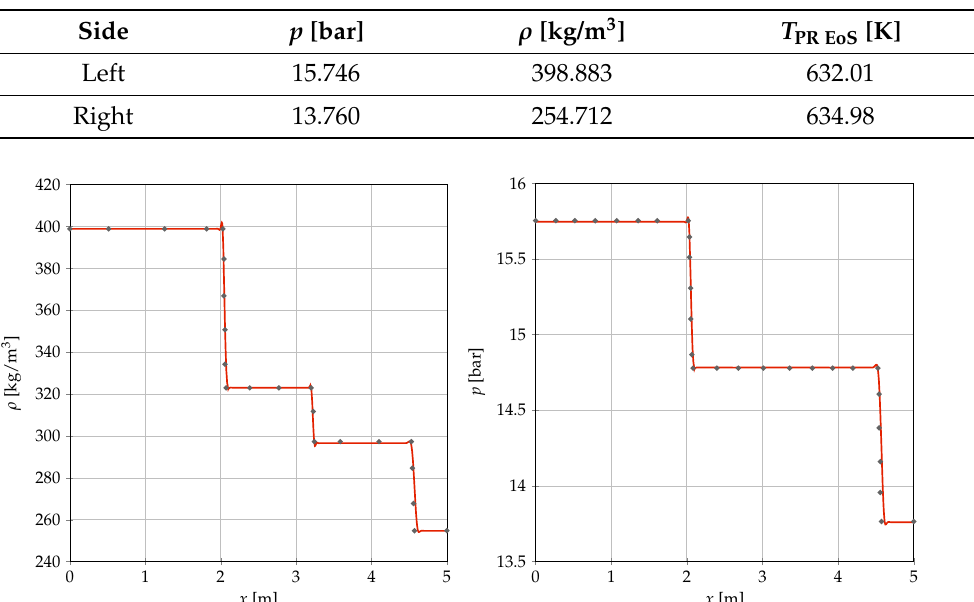
10 − 3 s. Guardone MH EoS [4], ×